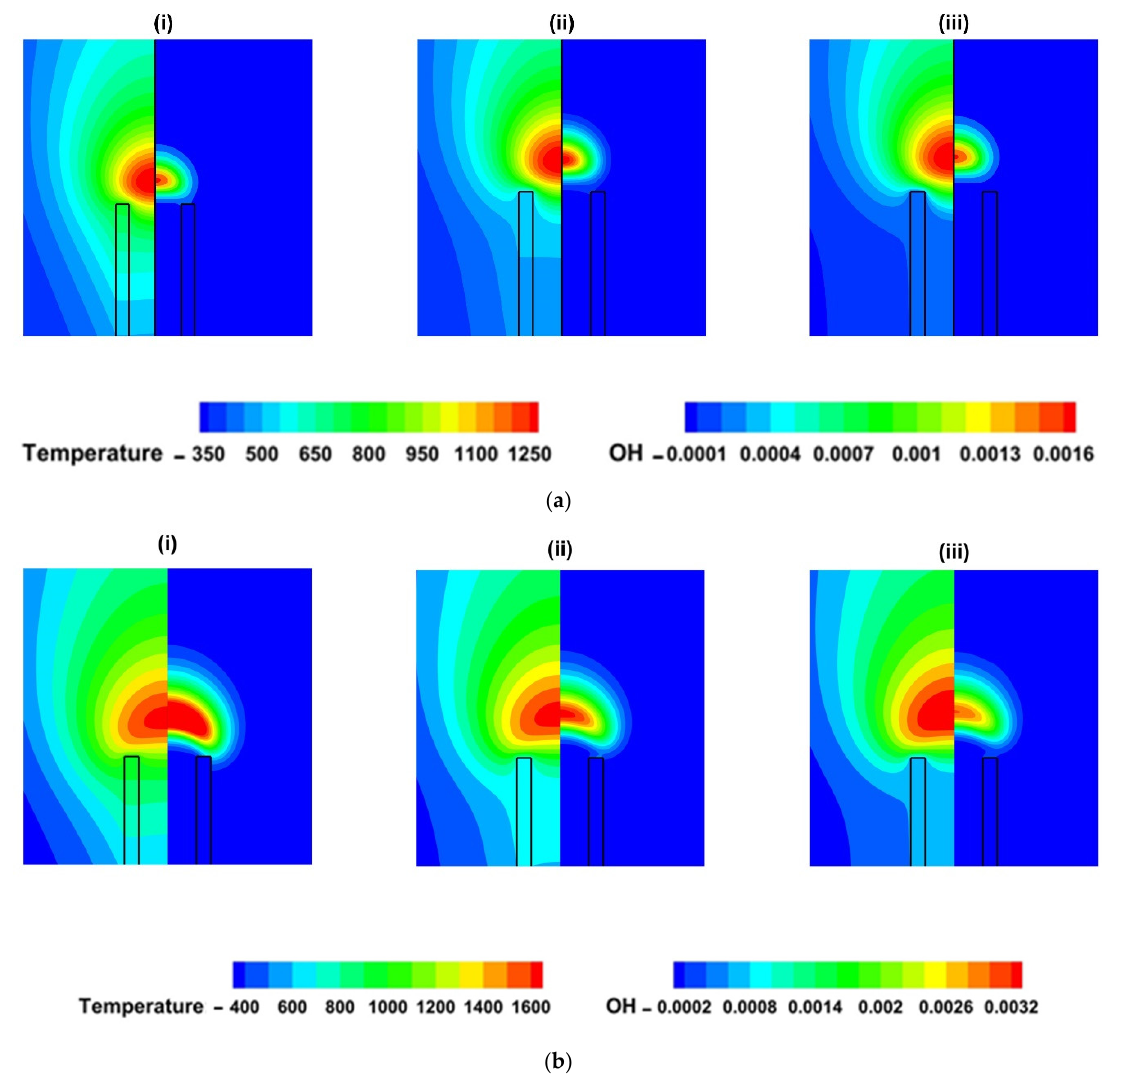
Figure 11. ( a ). Static temperature ( left hand side ) and OH mass fraction contours ( right side ) near extinction ( i ) quartz, v = 0.13 m/s, ( ii ) steel, v = 0.14 m/s and ( iii ) aluminum, v = 0.14 m/s. ( b ). Static temperature ( left hand side ) and OH mass fraction contours ( right side ) for fuel inlet velocity, v = 0.25 m/s ( i ) quartz, ( ii ) steel, and ( iii ) aluminum. The effect of burner wall material on OH mass fraction is negligible for near extinc- tion conditions. However, at higher fuel flow velocities (v = 0.25 m/s), the OH mass frac- tion changes significantly with a change in burner wall material, as shown in Figure 11b. Additionally, OH mass fraction contours are extended towards the burner top surface for quartz, whereas the amount of OH present near the burner wall is reduced for the case of steel and aluminum burners. Even though the overall flame shapes appear the same for all three materials, the flame structure near the burner tip is significantly different. There is an axially elongated temperature field downstream for the case of quartz burner. 3.3. Effect of Burner Wall Thickness on Flame Characteristics and Structure In order to investigate the effect of burner wall thickness on diffusion flame charac- teristics and structure, simulations were performed using burners with wall thicknesses of t = 0.1, 0.2, and 0.3 mm. Burner diameter, d = 0.8 mm, and the length, l = 10 mm, were kept constant for all three cases. Variation of non-dimensional flame heights along with the maximum flame tem- perature with the wall thickness of the burner tube is presented in Figure 12. It can be